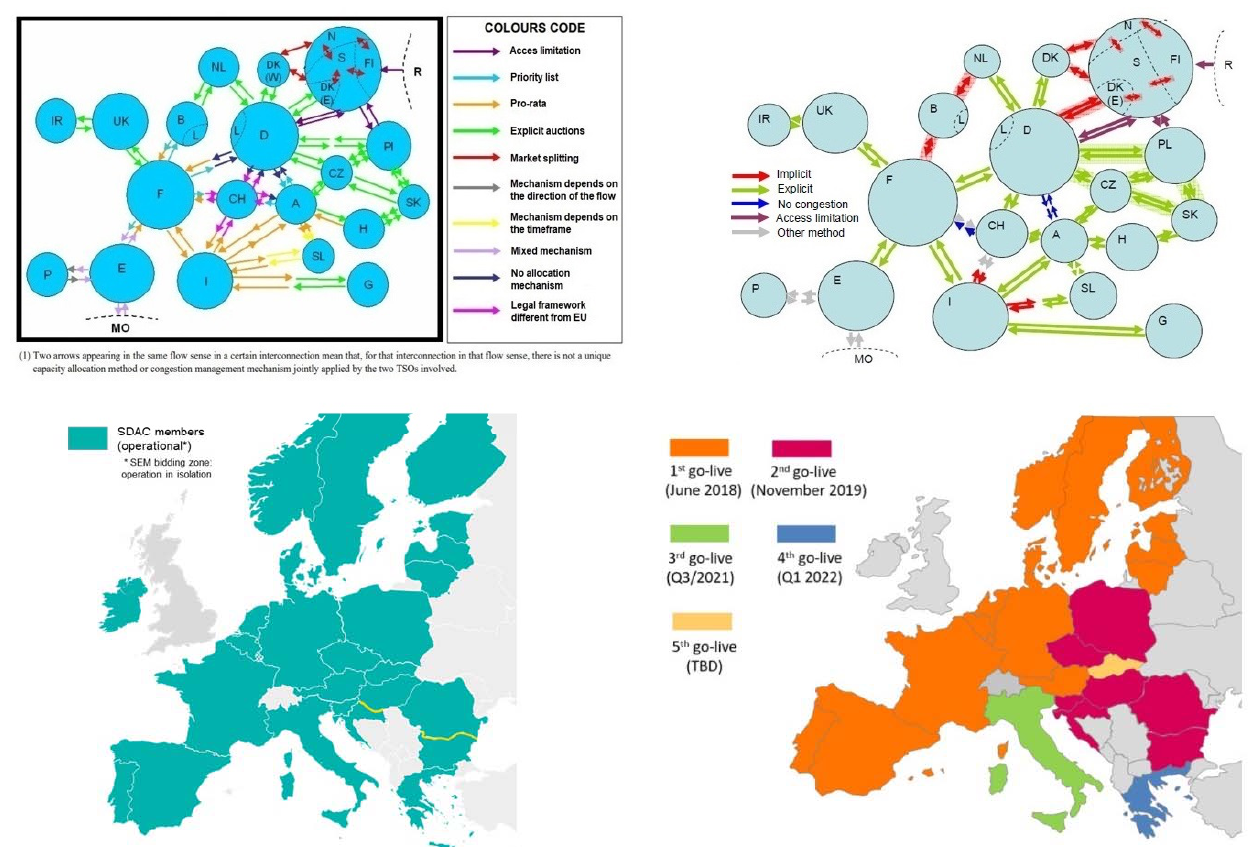
Figure 1. Four charts depicting gradual changes in the allocation of cross-border transmission rights in Europe. ( Top-left ) Status at the day-ahead timeframe in 2003 [13]. ( Top-right ) Status at the day-ahead timeframe in 2007 [14]. ( Bottom-left ) Current Single Day-Ahead Coupling (SDAC) in July 2021—borders in yellow are currently not coupled yet [15]. ( Bottom-right ) Evolution and future steps in the Single Intraday Coupling (SDIC) [16].